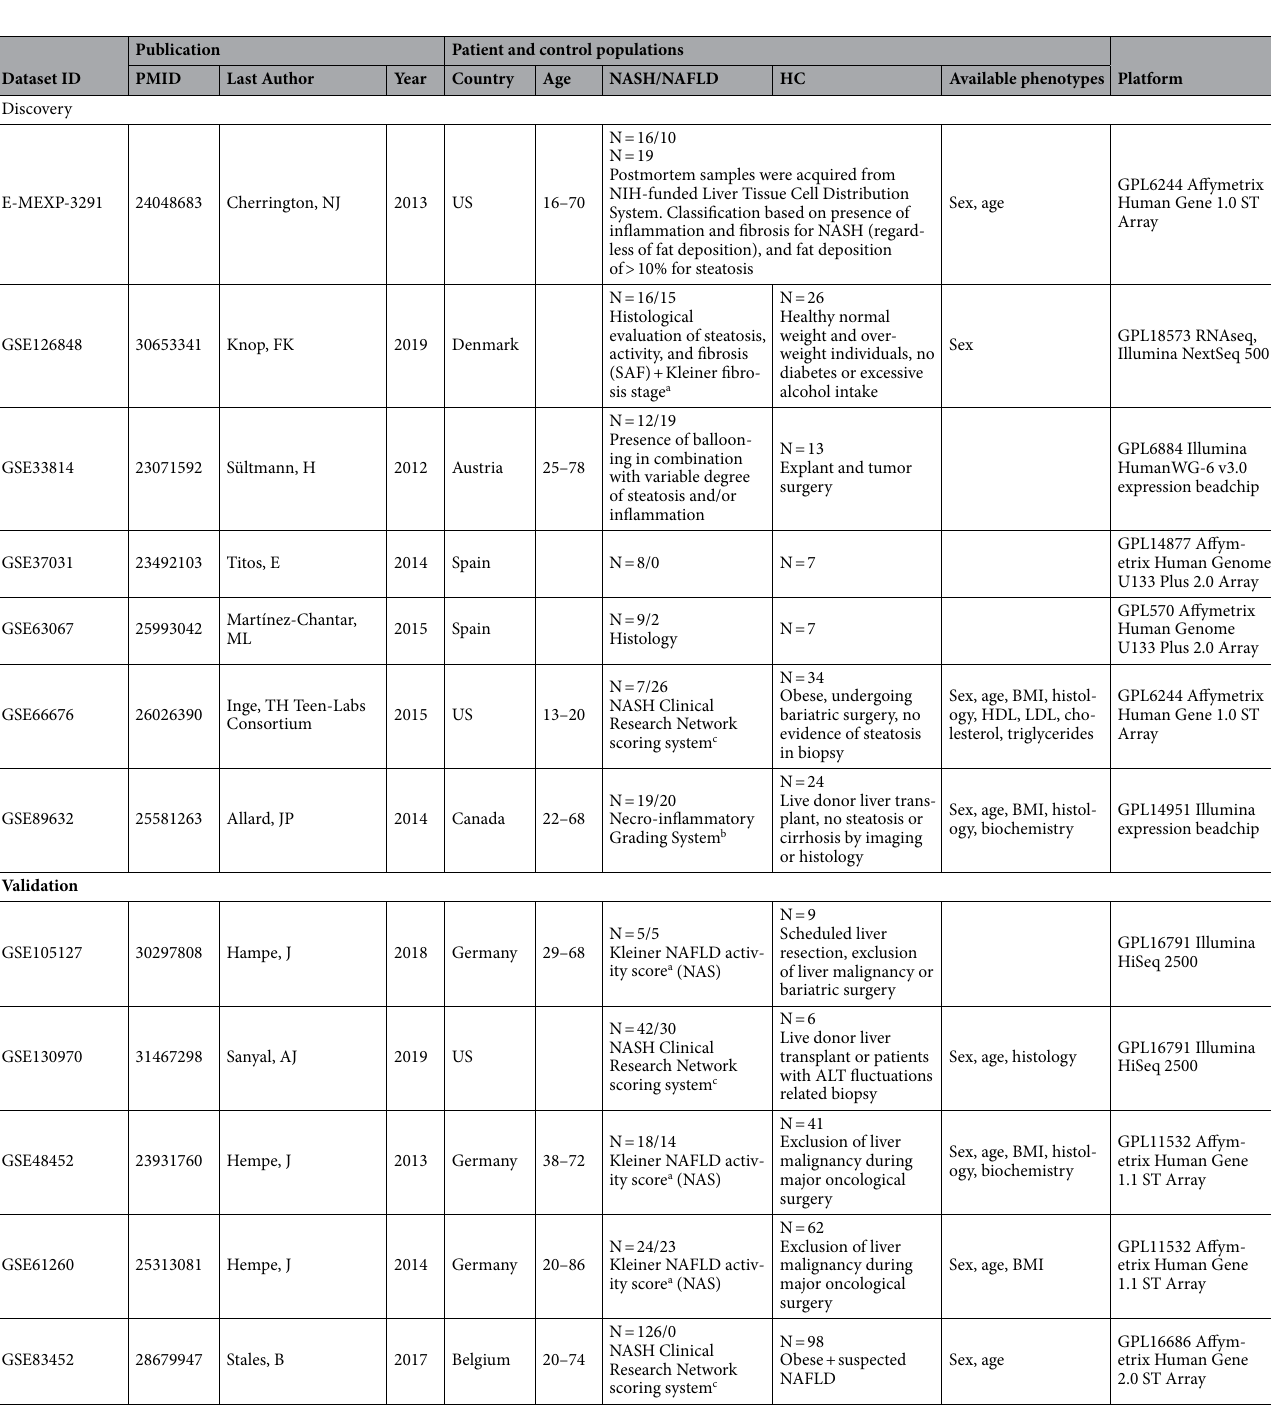
Table 1. Datasets included in multicohort analysis capture real world heterogeneity. The 12 datasets included in our analysis span multiple countries, age groups, diagnostic approaches, and technical variation in gene expression platforms. In the NASH/NAFLD and HC columns N indicates the number of samples in the relevant group. a Kleiner DE, Brunt EM 2005. b Brunt EM et al. 1999. c Xnathakos S